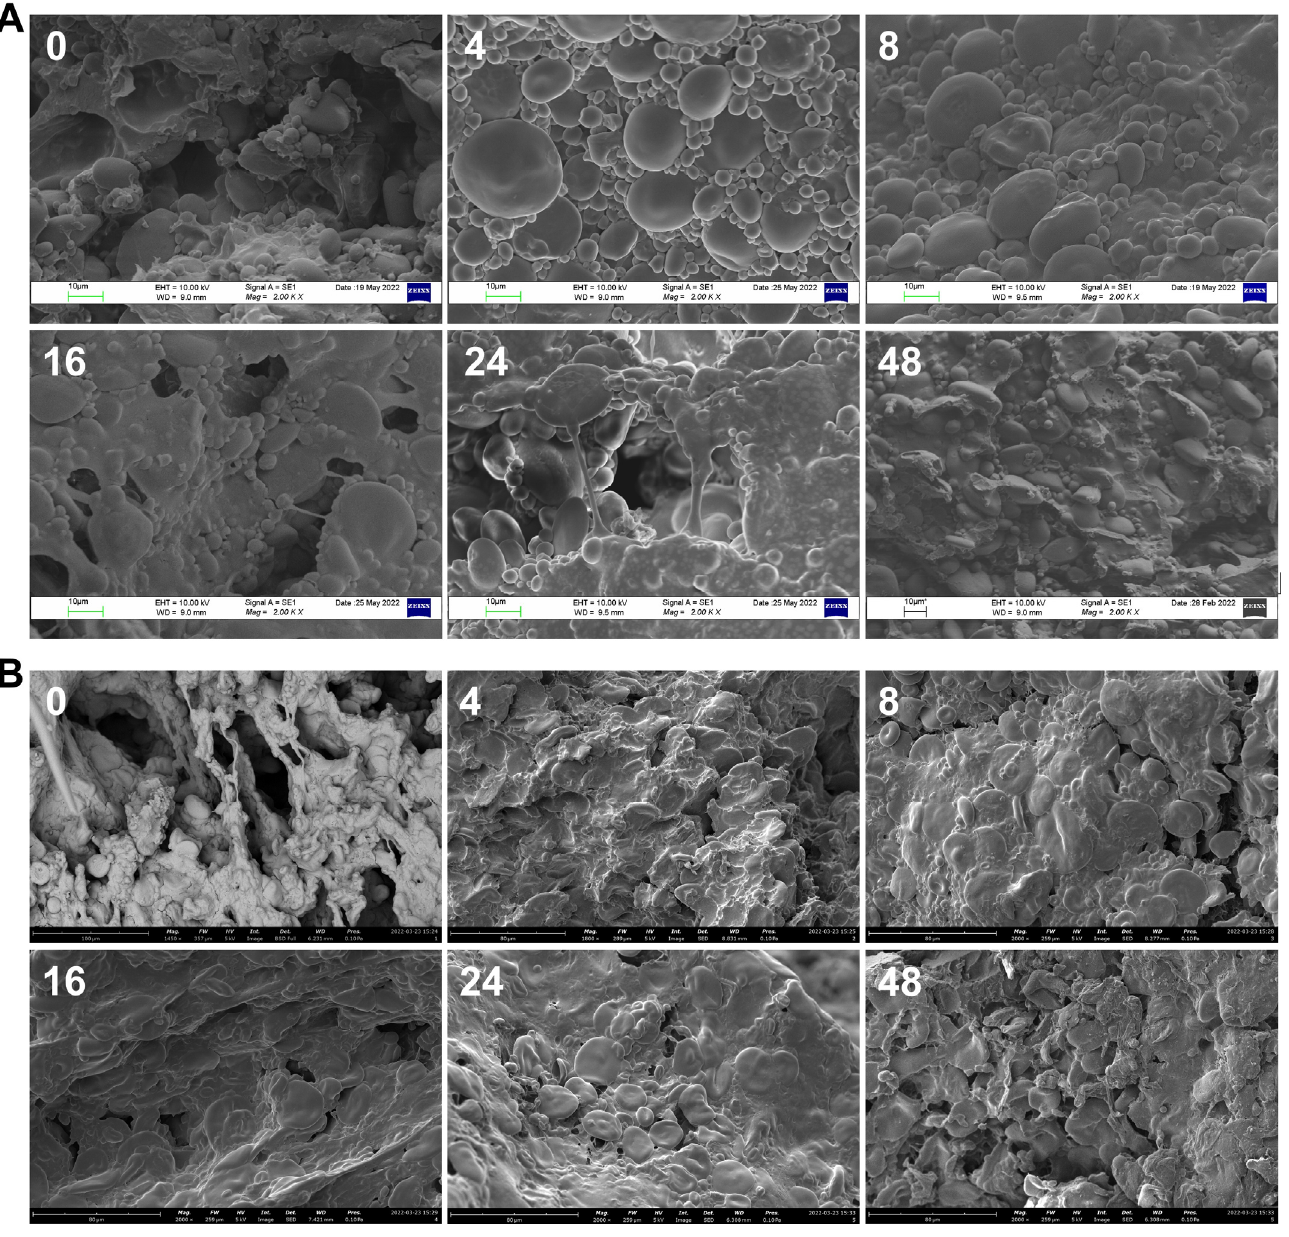
Figure 6. SEM images of dough ( A ) and a wood oven-baked pizza base ( B ) at a selected leavening time. Magnification: 2000 ×